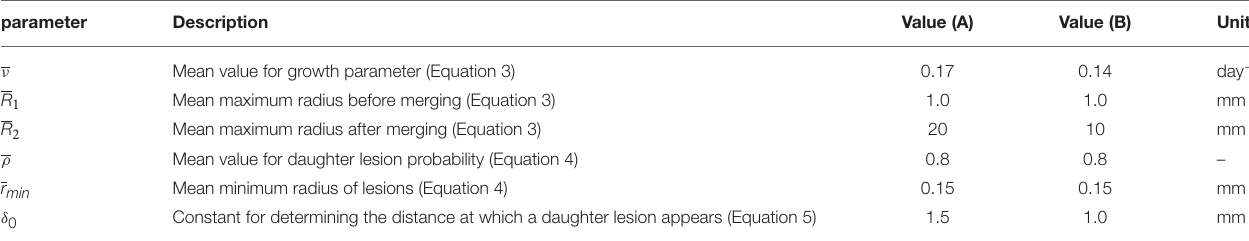
TABLE 1 | Parameters of the model after the parameter estimation process. parameter Description